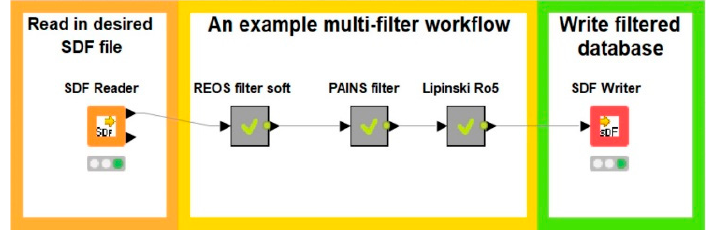
Figure 8. An example of combining meta nodes to form a complex drug design